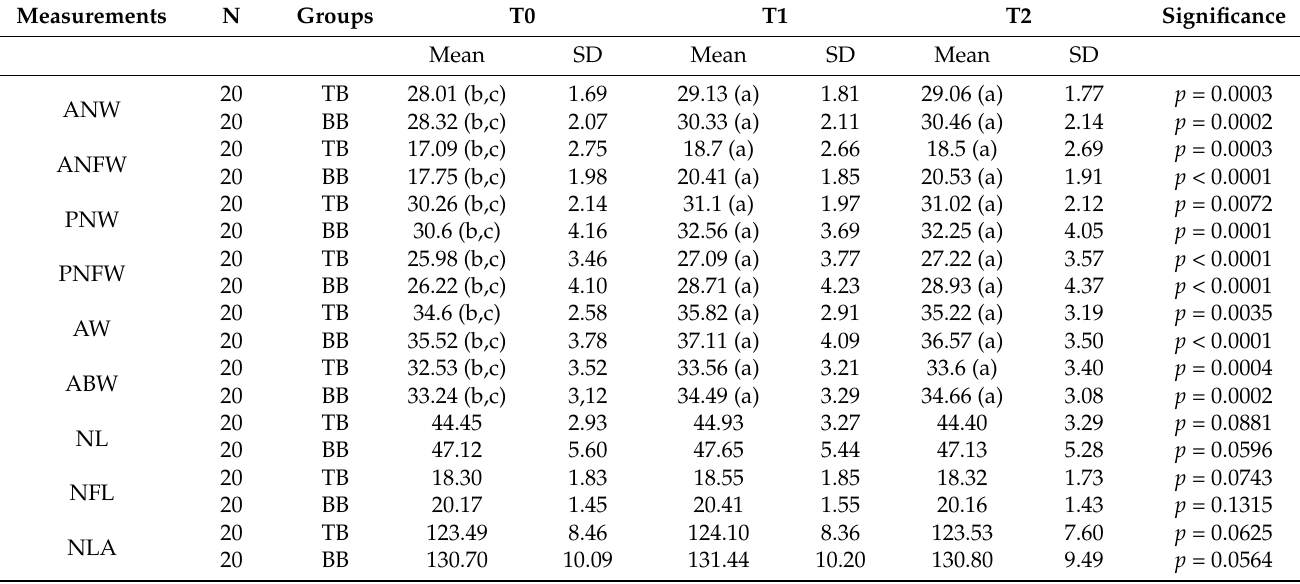
Table 3. Inferential statistics of measurements calculated before treatment (T0), after 6 months (T1) and one year after treatment